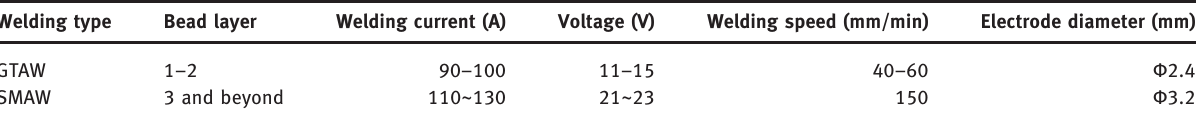
Table 2: Welding condition. Welding type